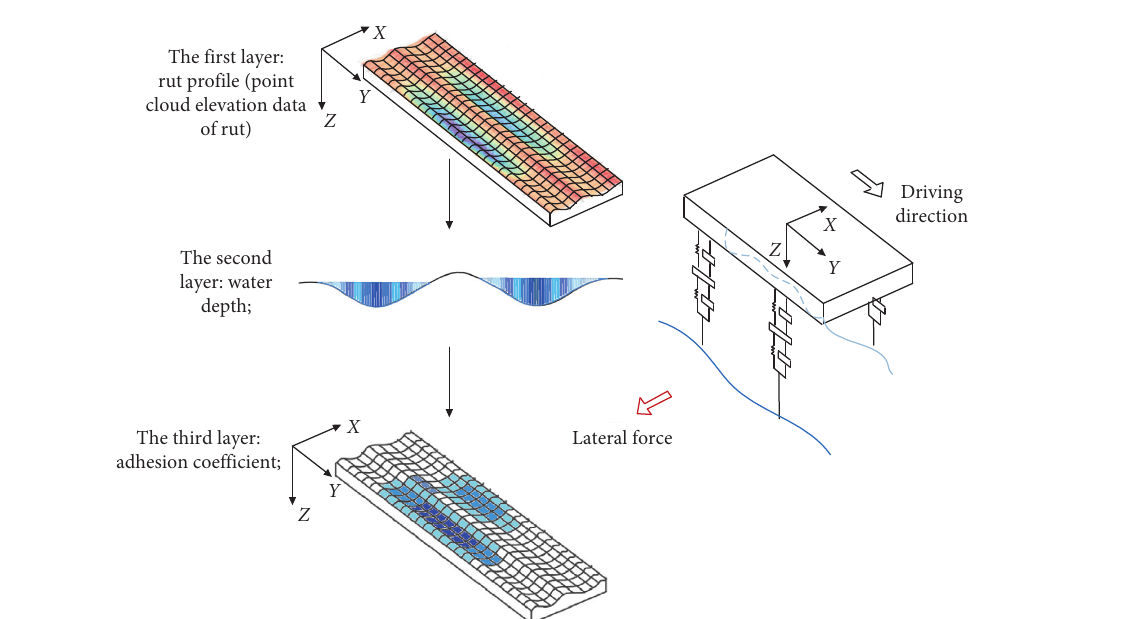
Figure 4: Schematic diagram of impact of the water-filled rut on vehicle